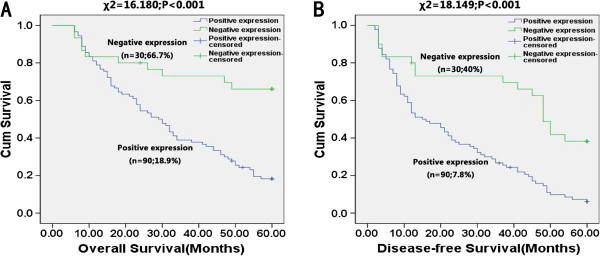
Overall survival and disease-free survival curves constructed by Kaplan-Meier analysis, grouped by HSPA2 expression (negative expression, positive expression). (A) Overall survival and (B) disease-free survival curves. Log-rank test (A: χ2 = 16.180, P <0.001; B: χ2 = 18.149, P <0.001) demonstrated that ESCC patients in the HSPA2-positive expression group had shorter overall survival and poorer disease-free survival compared with those in the HSPA2-negative expression group. Three patients were lost to follow-up because of telephone number changes or home moving. ESCC, esophageal squamous cell carcinoma.